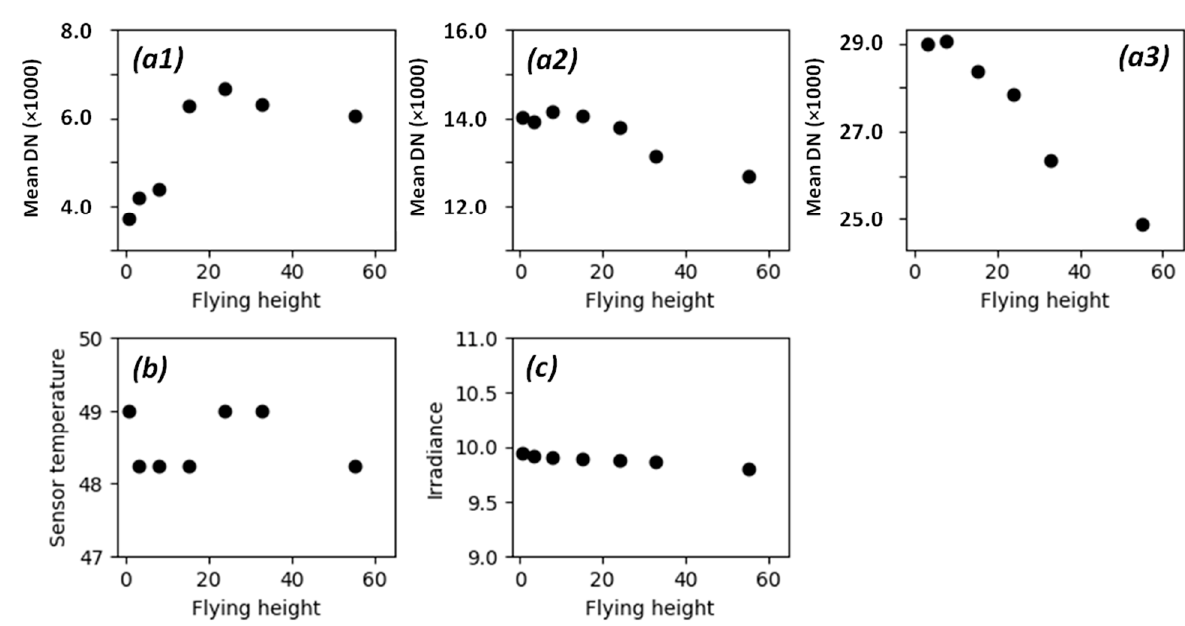
Figure 15. Mean pixel values for the near infrared band over the 5% ( a1 ), the 20% ( a2 ), and the 50% ( a3 ) reflectance calibration panels during the flight on 20 May 2019. Images were captured while descending over the panels with stable camera temperature ( b ) and irradiance ( c ).